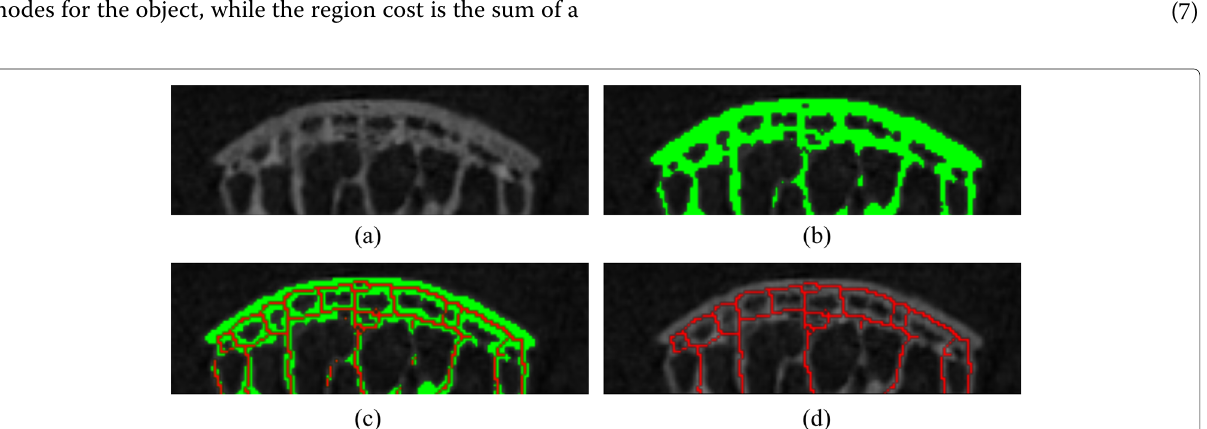
Fig. 9 The skeletonisation process. a The input image. b The mask image resulting from a , where the foreground bone tissues are in green. c Skeletonisation result from b , where skeletons are in red. d The final skeleton used for graph construction after removing some